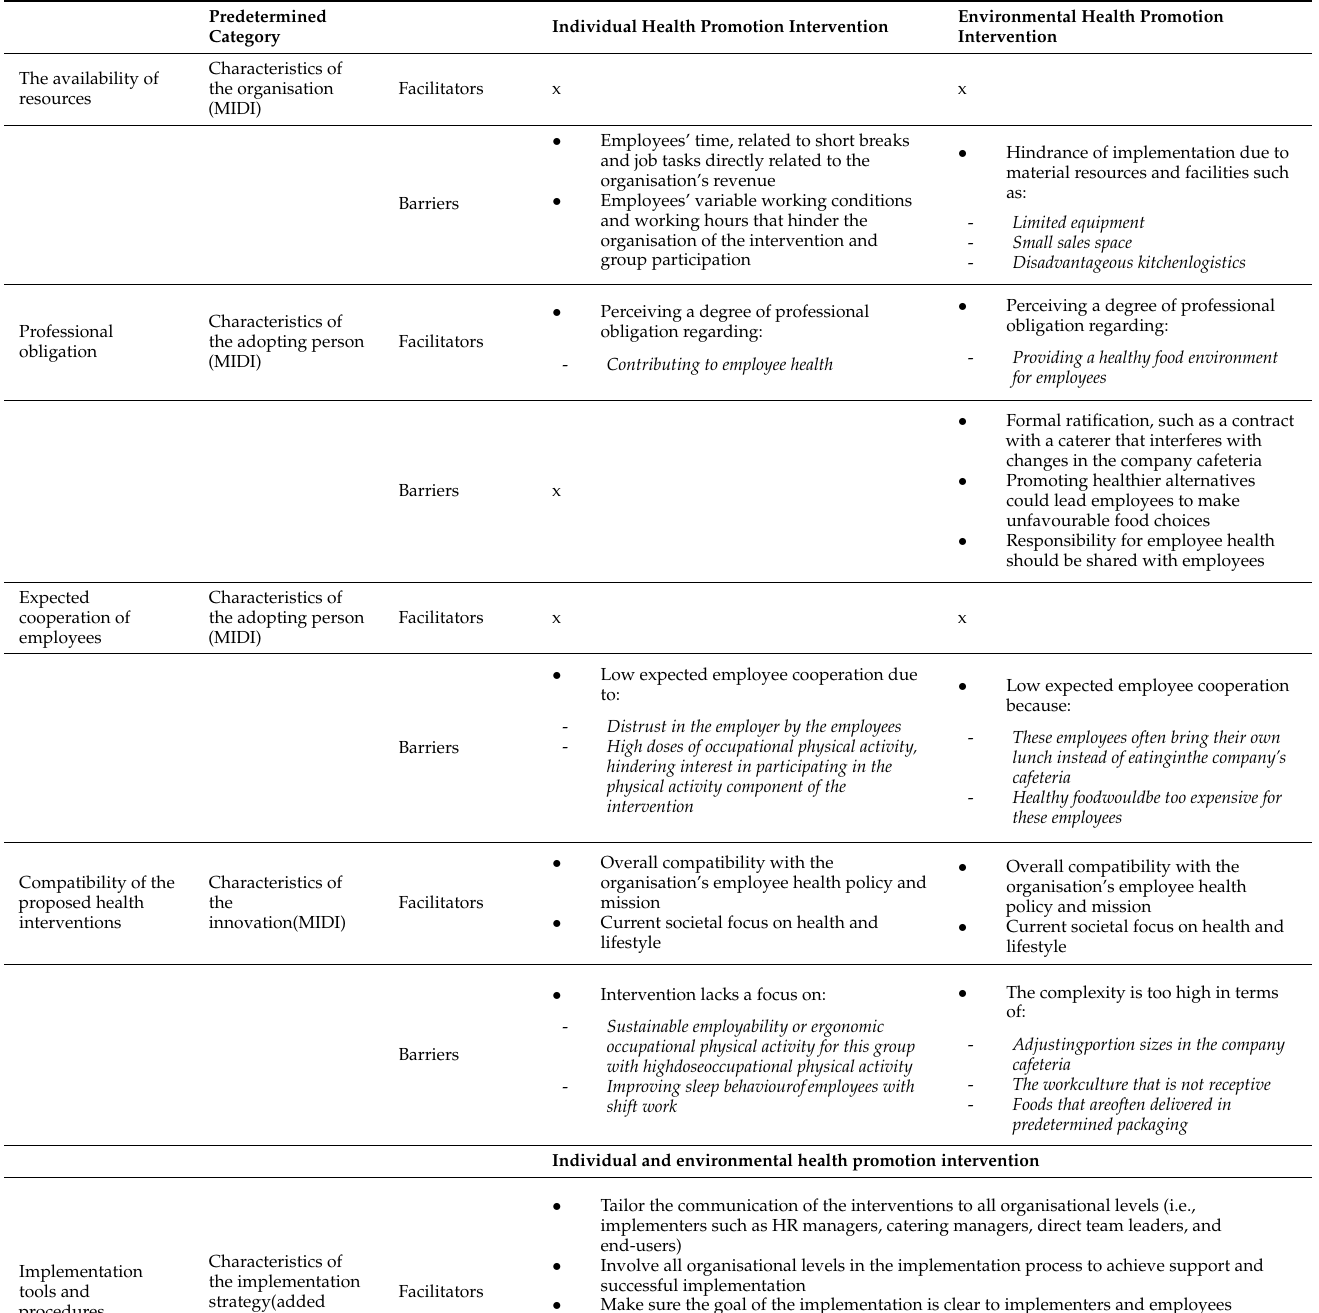
Table 2. Themes resulting from the data analysis, categorised by facilitators and barriers of both health promotion